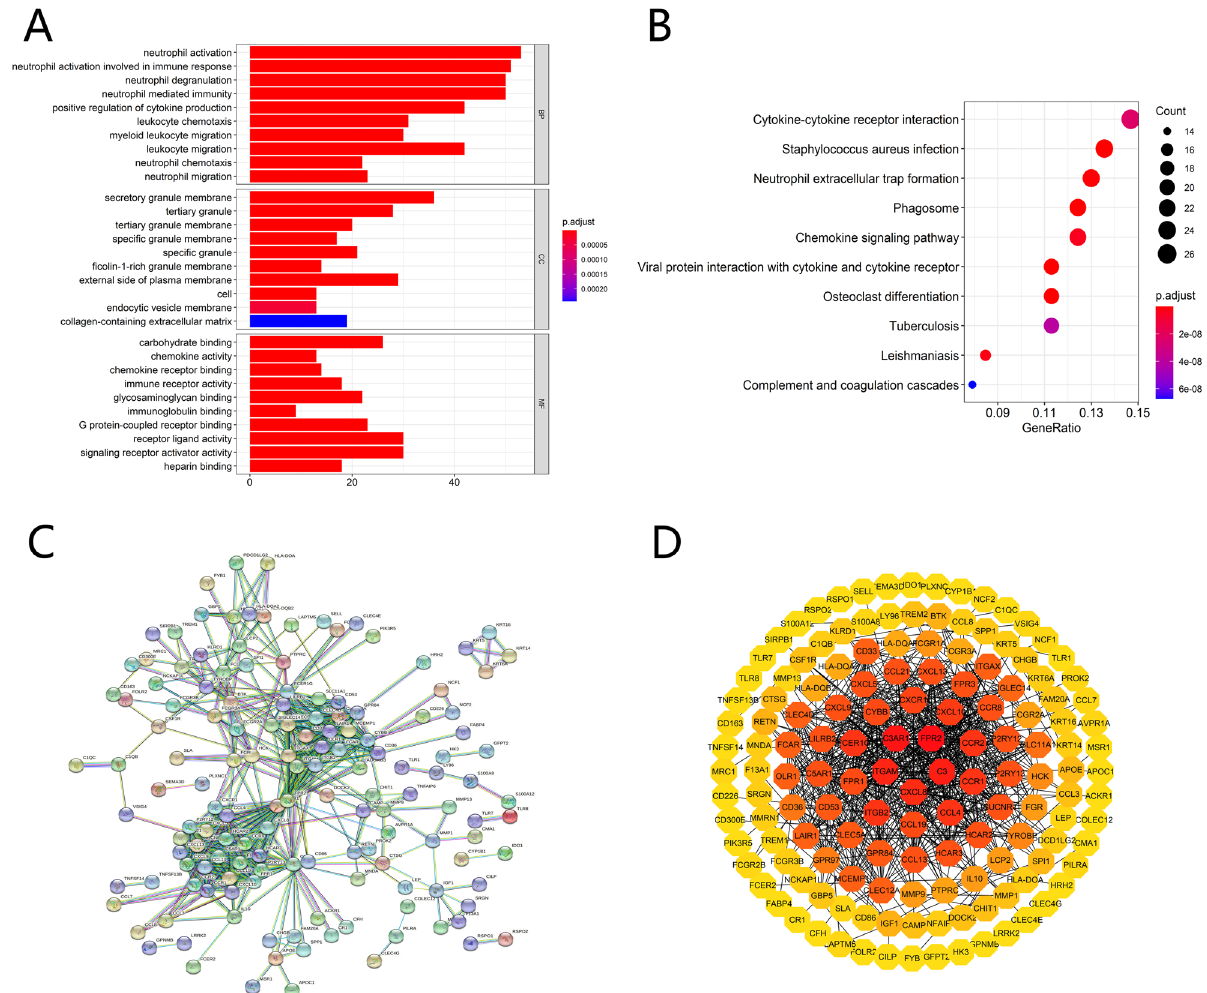
Figure 3. GO functional enrichment analyses, KEGG pathway analyses, and PPI network of DEGs. ( A ). The top 30 significantly enriched GO terms, including biological process (BP), molecular function (MF), and cellular component (CC). ( B ). KEGG pathway analyses of DEGs, The top 10 pathway enrichment was shown. The PPI network of the TME-related DEGs ( C , D ). [STRING, https:// string- db. org/; Cytoscape (https:// cytos cape. org/; version